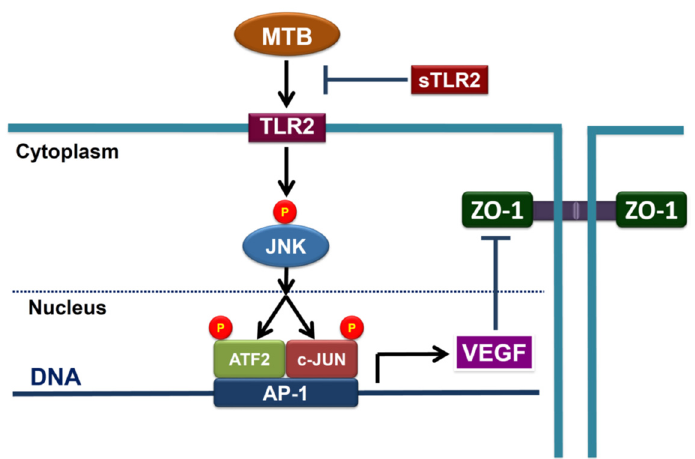
Figure 9. Schematic diagram of the cellular mechanism underlying pleural mesothelial hyperper- meability in tuberculous pleural effusion. TLR2 mediates Mycobacterium tuberculosis -activated cel- lular processes in human pleural mesothelial cells by triggering JNK/AP-1 signaling to induce VEGF production and thereby downregulate ZO-1 expression, leading to pleural mesothelial hyperper- meability. Moreover, sTLR2 serves as a decoy receptor to reduce TLR2-mediated inflammation.